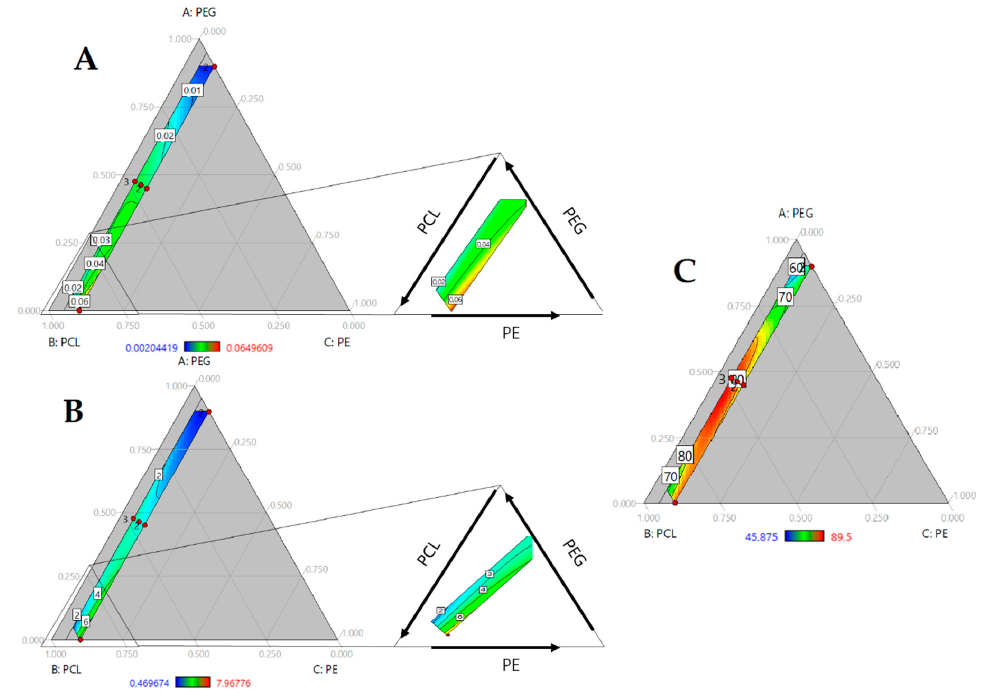
Figure 5. Ternary contour plots of ( A ) Modulus in MPa; ( B ) Tensile strength in MPa and ( C ) Shore A Hardness as function of PEG, PCL and PE mass fraction.